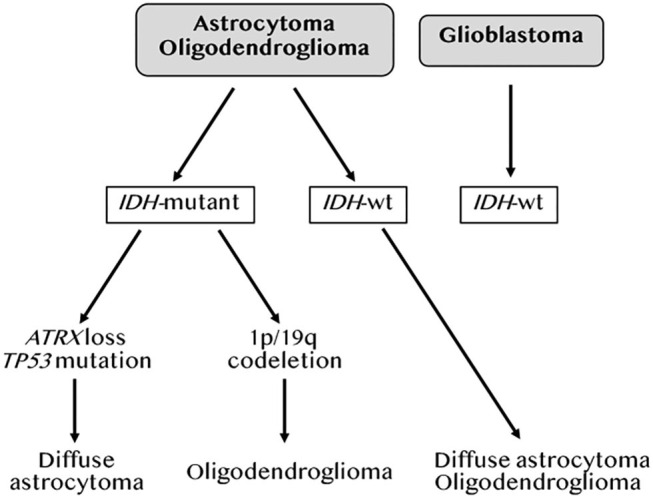
Molecular classification of gliomas. Adapted from the 2016 WHO classification of brain tumors by DeWitt JC et al. (26).